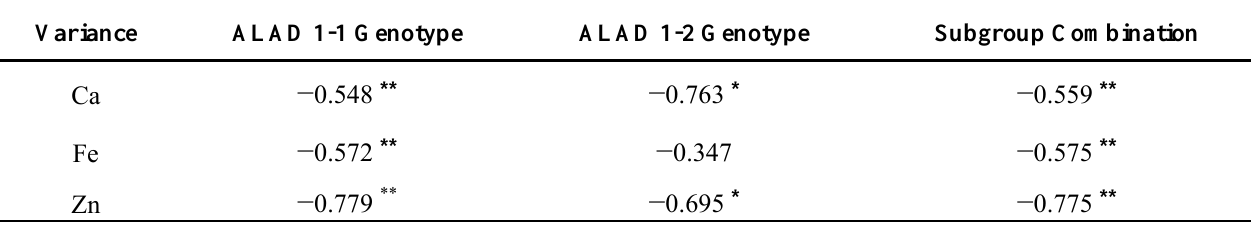
Table 5. Correlations between serum calcium, iron and zinc with blood lead level by